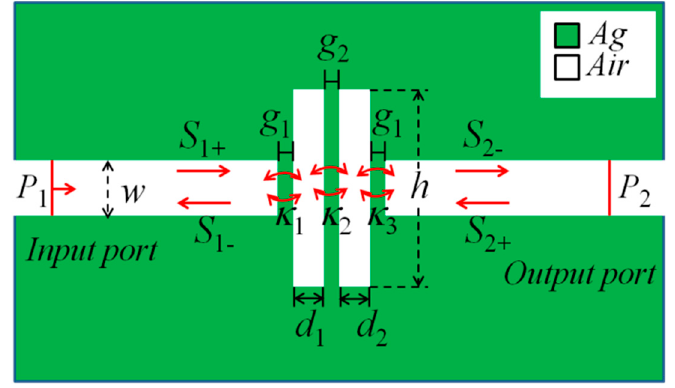
Figure 1. Schematics of the proposed MIM waveguide-coupled double rectangular cavities.